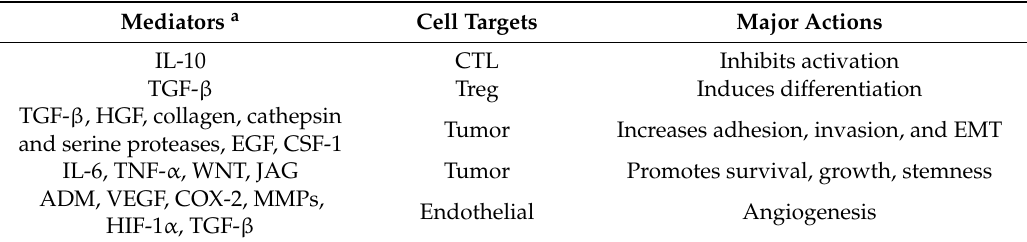
Table 2. Immune dysregulation by TAMS in the